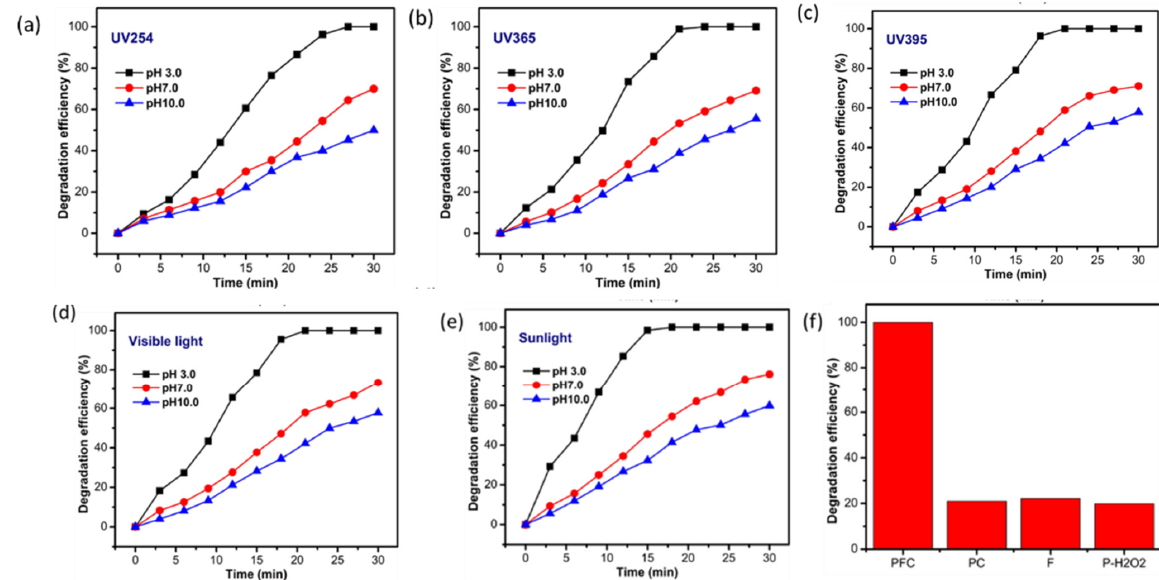
Figure 5. Photodegradation activity of rGO-ZrO 2 ( a ) UV 254 nm, ( b ) UV 365 nm, ( c ) UV 395 nm, ( d ) Visible light and ( e ) sunlight ( f ) Comparison of various methods with present studies, PFC: Photo Fenton’s with rGO-ZrO 2 catalyst, PC: Photocatalyst (FO), F: Fenton’s process, P-H 2 O 2 : Photo process with hydrogen peroxide at pH 3.